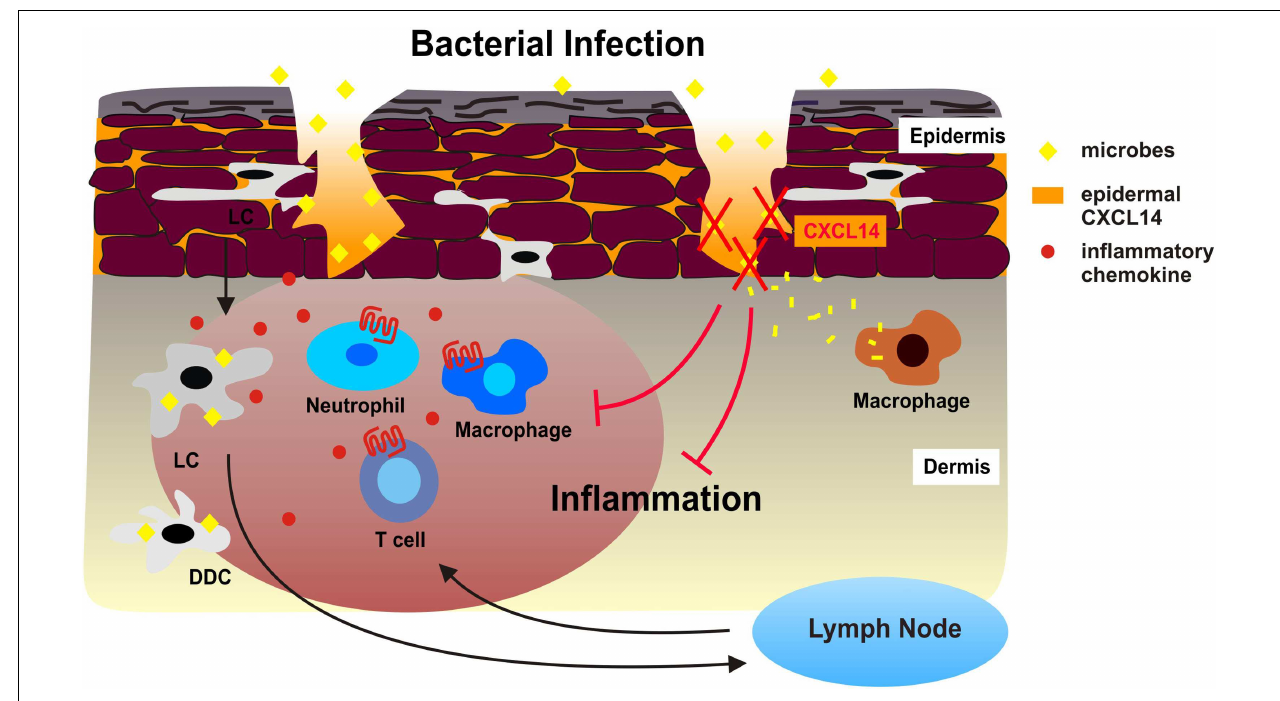
the site of microbial infection.The combination of innate and adaptive immune responses may exacerbate tissue inflammation.We propose that the high levels of CXCL14 in the epidermis neutralize microbes that enter the skin during micro-injuries and dermal macrophages then clean-up bacterial debris. This instant antimicrobial system safeguards the skin from excessive cellular immune responses, thereby contributing to the maintenance of tissue